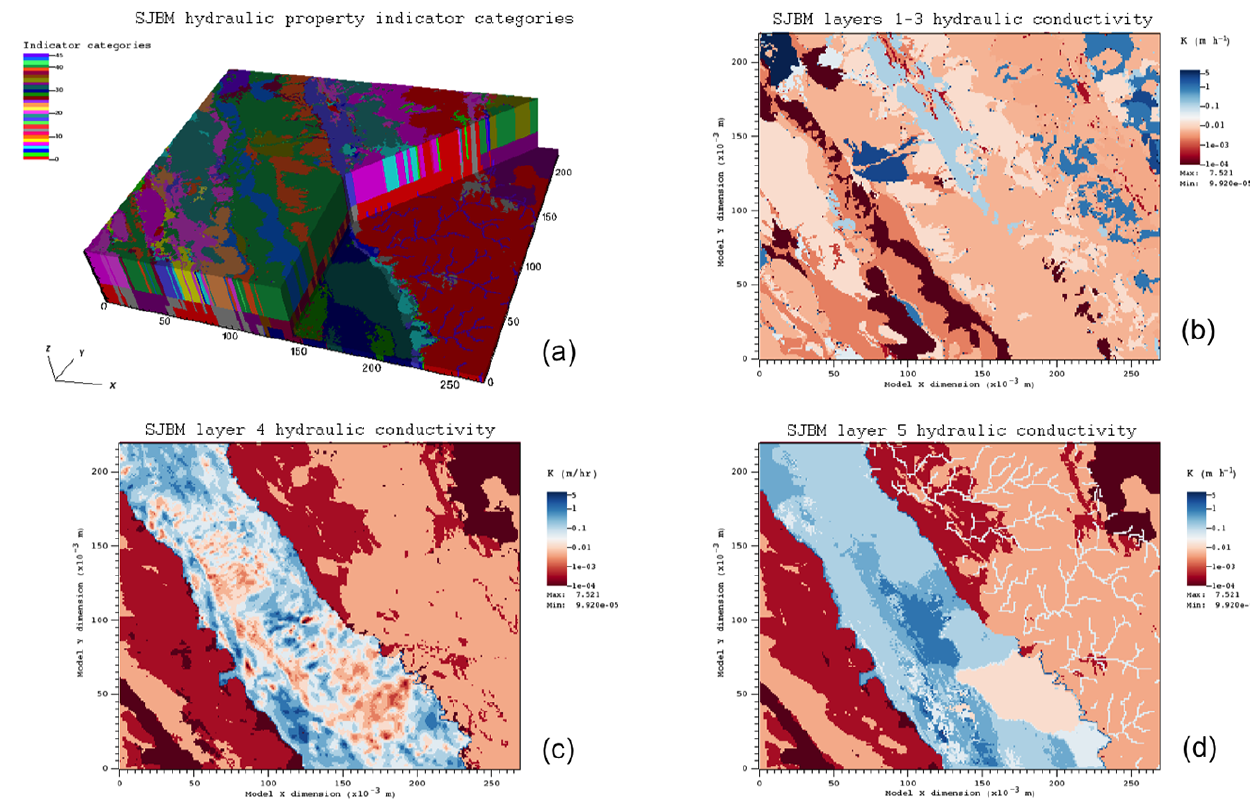
Figure B1. Spatial distribution of subsurface hydraulic property indicator categories (a) , hydraulic conductivity (mh − 1 ) in the top 1m of the model grid (layers 1–3) (b) , hydraulic conductivity in model layer 4 (c) , and hydraulic conductivity in the bottom model layer (layer 5) (d) . Note in (a) that each layer is shown with an equal thickness and a vertical exaggeration of